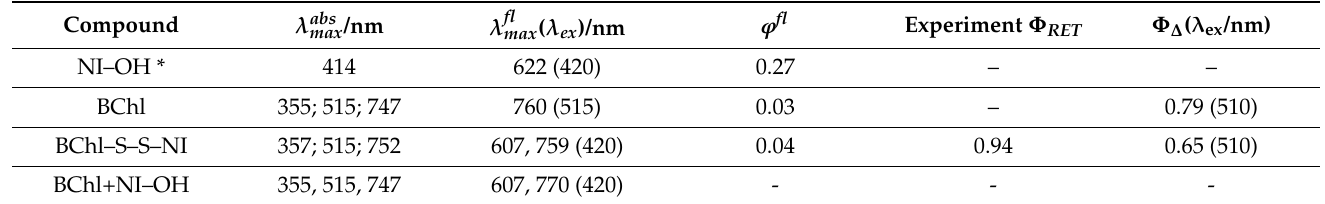
Table 1. Photophysical characteristics of compounds NI–OH, BChl, BChl–S–S–NI, and BChl+NI–OH in